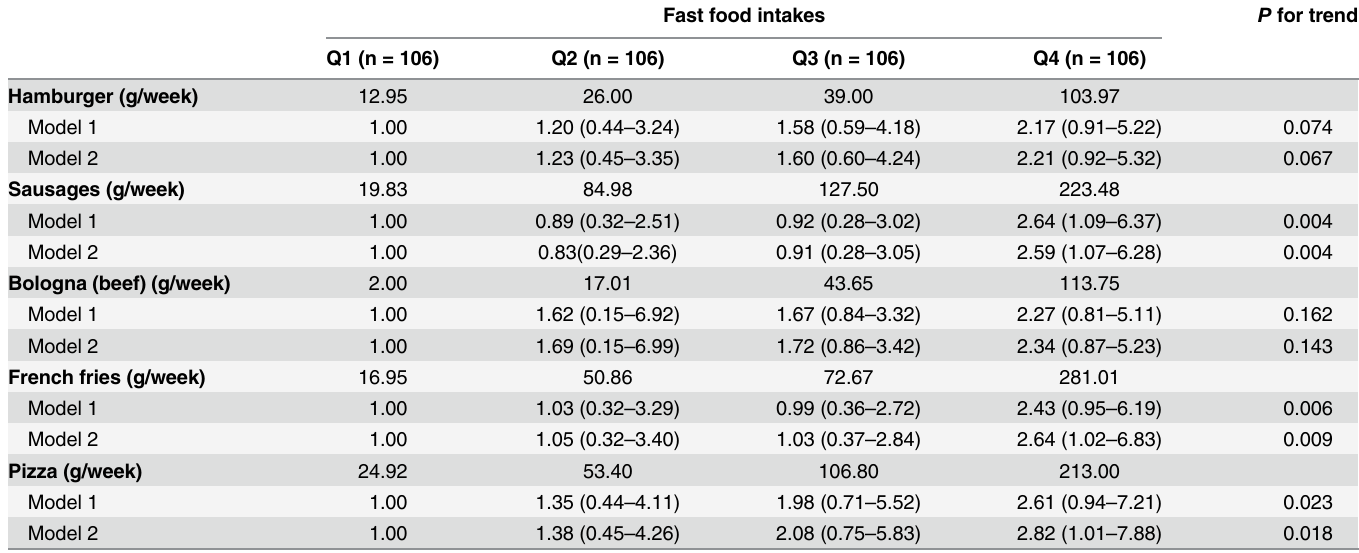
Table 4. Multivariable-adjusted odds ratio (95% CIs) for incident metabolic syndrome according to quartiles of fast food items, among children and adolescents during 3.6-year follow-up.